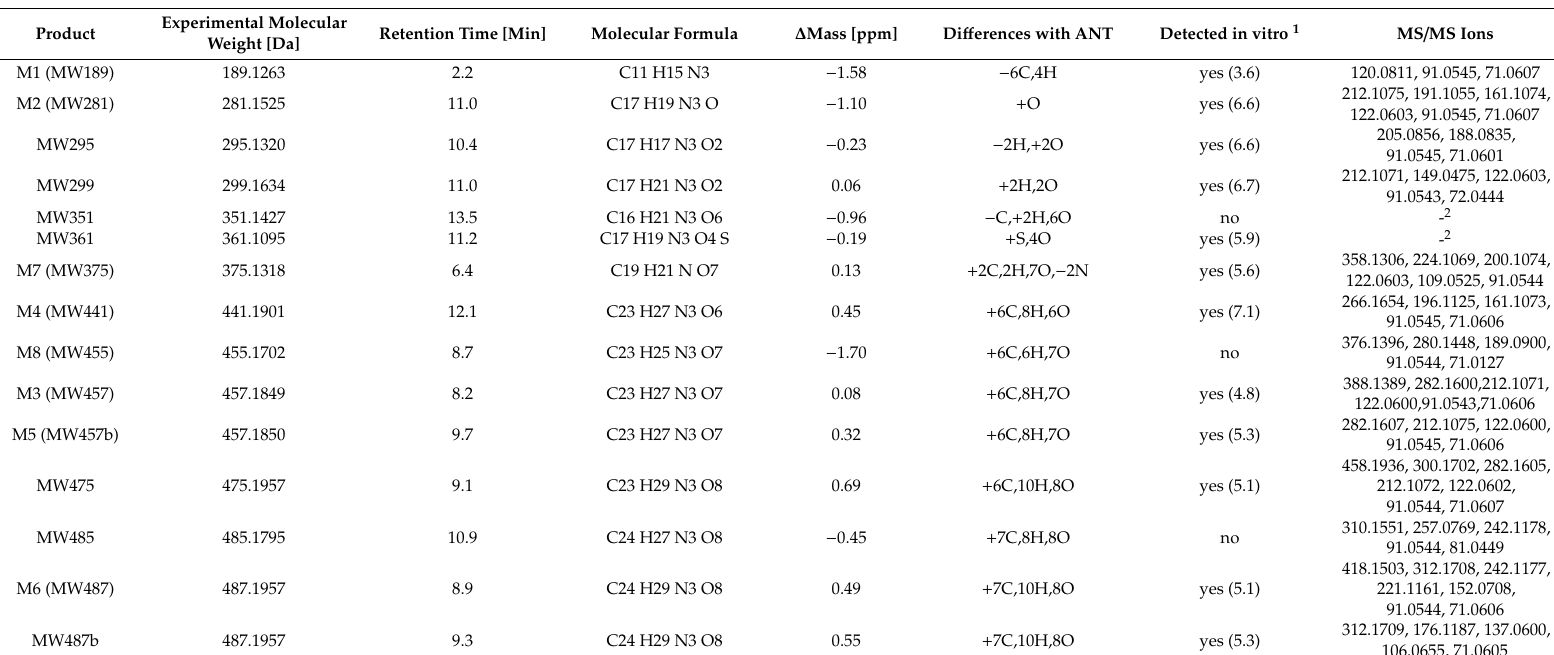
Table 1. Experimental molecular weight, the di ff erence between the theoretical and experimental molecular weight, retention time, molecular formula, and the most abundant daughter ions (normalized collision energy of 20, 35, 50 eV) of the tentative metabolites of